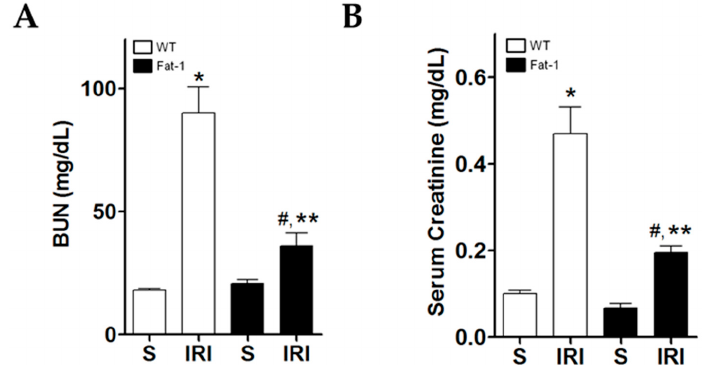
Figure 1. Renal function (WT-S, wild type sham; WT-IRI, ischemic-reperfusion renal injury (IRI) in wild-type mice; fat-1, fat-1 induction sham; fat-1 ischemia-reperfusion injury (IRI), ischemia- reperfusion (IR) renal injury in fat-1 induction mice). The levels of ( A ) blood urea nitrogen (BUN); and ( B )